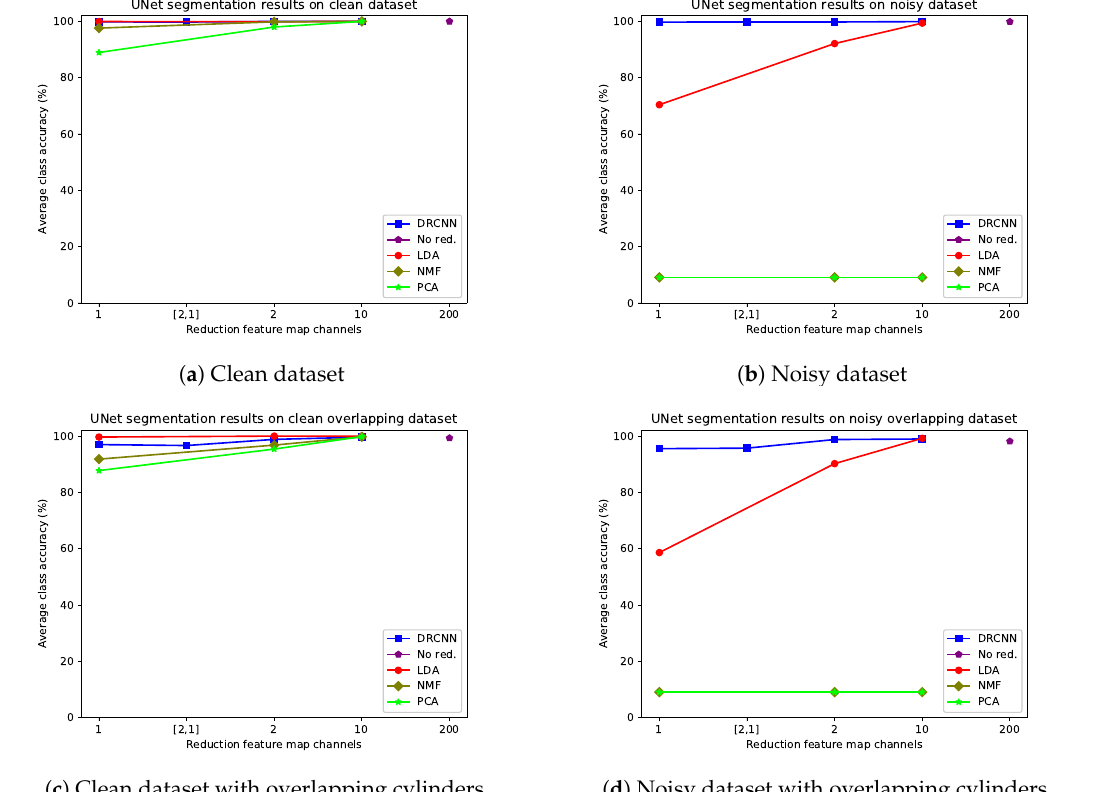
Figure 15. Average class accuracies for different reduction schemes with U-Net as CNN for different simulated remote sensing datasets: clean dataset ( a ), noisy dataset ( b ), clean overlapping dataset ( c ) and noisy overlapping dataset ( d ). The layered reduction to 2 and then 1 feature map channel(s) is indicated by [ 2,1 ]